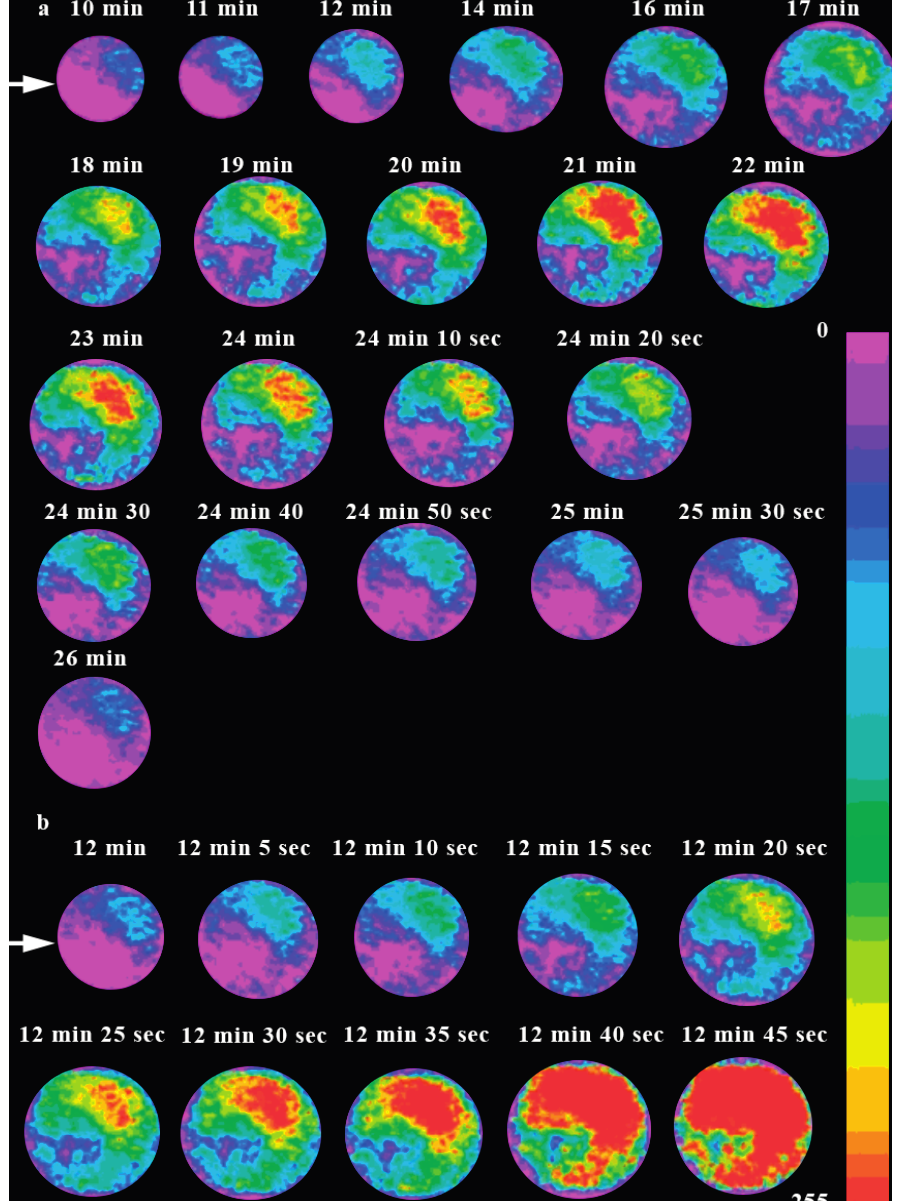
Figure 2. [Ca 2+ ] cyt ratio-imaging in immature and mature wheat egg cells at the focal plane of sperm incorporation. ( a ) The rise of a truncated [Ca 2+ ] cyt transient confined to a distinct region of the cytoplasm of the female gamete of wheat isolated three DAE and fused with a sperm cell. [Ca 2+ ] cyt elevation ensued approximately 10 min after sperm–egg fusion. Note that the site of the origin of the [Ca 2+ ] cyt transient is away from the fusion site (indicated by the arrows) of the male gamete and that the diameter of the pseudocolor-coded image sequences changes, so as to enhance the representation of the change in [Ca 2+ ] cyt elevation in such a way that the larger the diameter of the image, the higher the [Ca 2+ ] cyt concentration; the arrow indicates the sperm entry site; ( b ) [Ca 2+ ] cyt wave of a mature (six DAE) wheat egg cell sweeping through the whole cytoplasm of the cell approximately 12 min after plasmogamy. Note that the origin of the [Ca 2+ ] cyt wave is away from the sperm entry site. The arrow shows the sperm entry